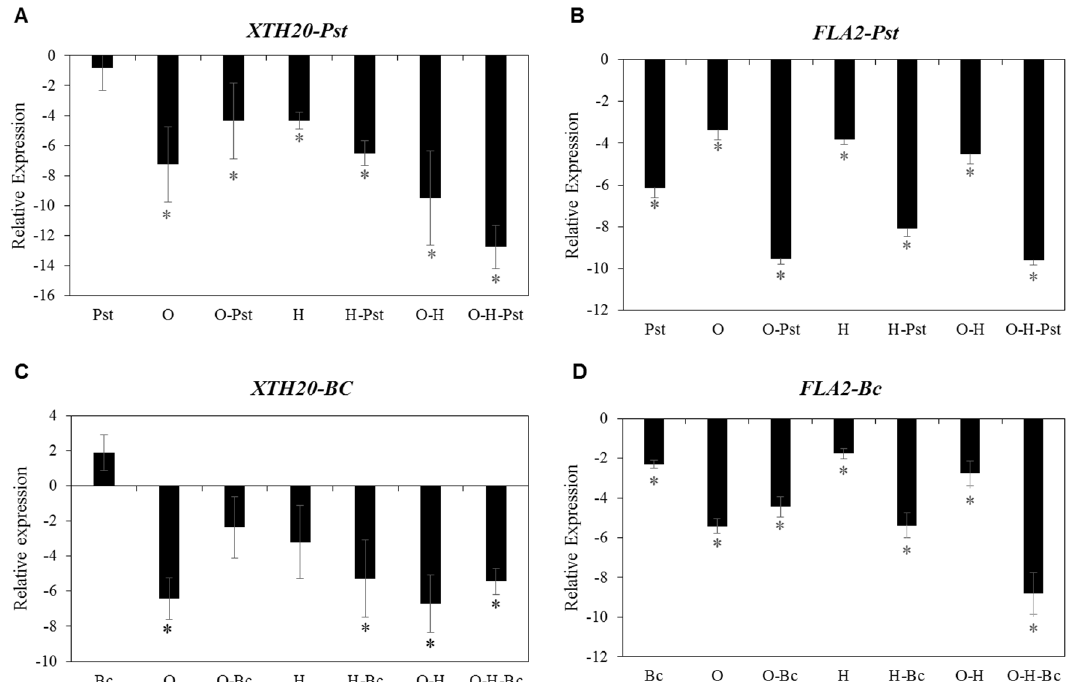
Figure 5. Effect of individual and combined osmotic, heat, Pseudomonas syringae pv. tomato DC3000 ( Pst ) ( A , B ) or Botrytis cinerea ( Bc ) ( A , D ) treatments on the expression of AtXTH20 ( A , C ) and AtFLA2 ( B , D ) genes in Arabidopsis plants (Col-0). Pst and Bc were applied 16 h after the abiotic stress treatments. Leaves were sampled 48 h after mock or pathogen treatments. O: osmotic stress, H: heat. Data are represented as log2 fold change, normalized with reference gene (plant biomass expressed protein, expG) and relative to the control. The zero-line represents mock treated plants. Bars represent the mean and standard deviation of three biological replicates. Asterisks indicate significant differences, 1-way ANOVA; post-hoc LSD, * p <